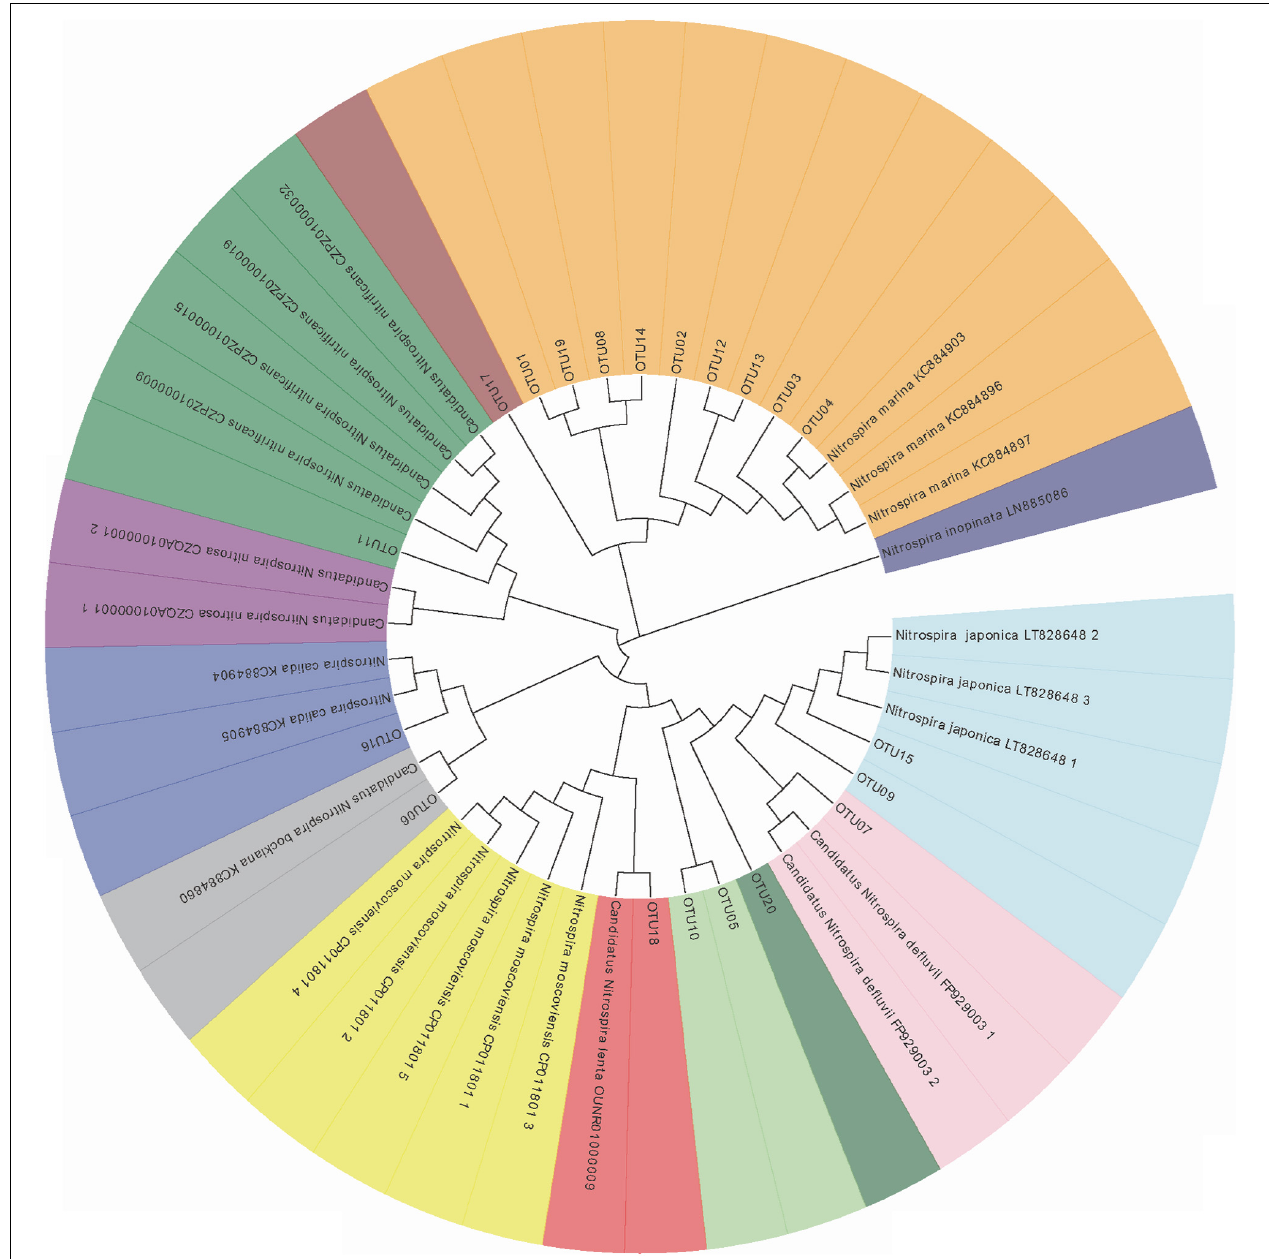
FIGURE 2 | Neighbor-joining phylogenetic tree exhibiting the clustering relationship between the known Nitrosopira species and representative sequences of dominant OTUs obtained from the DYB (STE). Sequences with bootstrap value (1000 replicates) higher than 50% were grouped together and are shape with the same